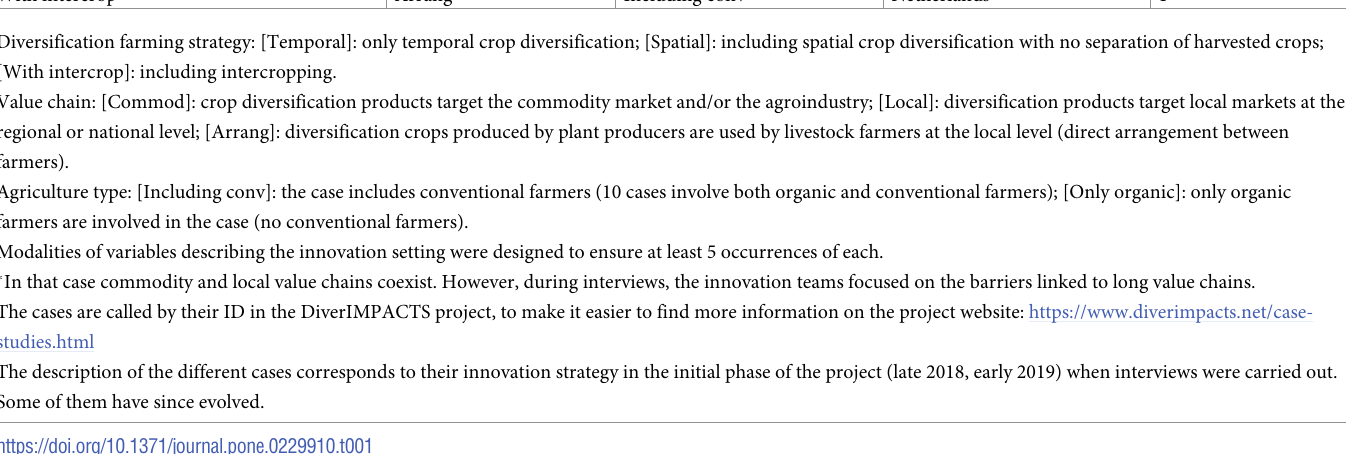
• Temporal crop diversification : new crops are integrated into the crop rotation before or after another crop, either as a main cash crop (e.g. introducing sunflower after maize), as a fodder crop (e.g. introducing a 2-year cycle of alfalfa before wheat) or as a winter cover crop (e.g. sowing a plant mixture including leguminous crops to cover the soil and absorb nutri- ents during winter after a crop harvested in summer and before sowing a crop in the spring); • Spatial crop diversification (with no separation of harvested crops): new and/or pre-exist- ing crops are combined at the same time on the same plot to increase biodiversity and spatial